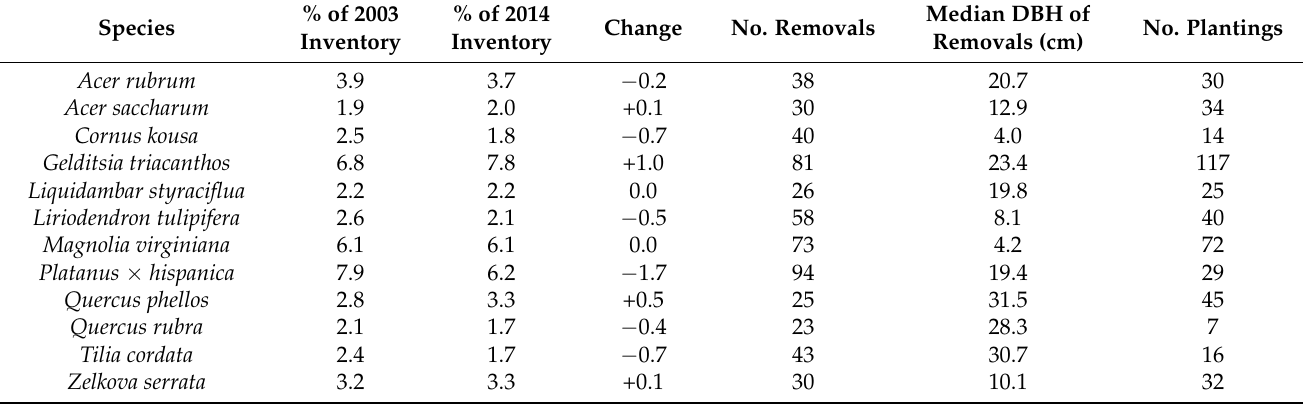
Table 4. Most common species in 2003 and 2014. Only species representing 2% or more of the total in either inventory are included, and trees identified to the genus level only (e.g., Acer sp., Prunus sp.) are not included here. These 12 species account for 44.4% of all trees in 2003 and 41.9% in